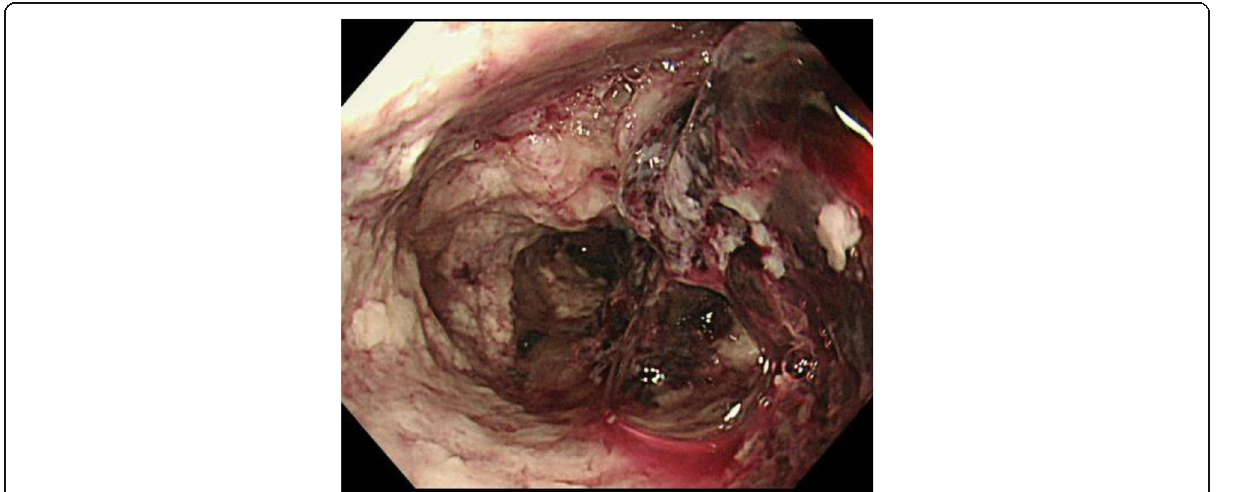
Fig. 5 Colonoscopy showing hemorrhagic circumferential ulceration